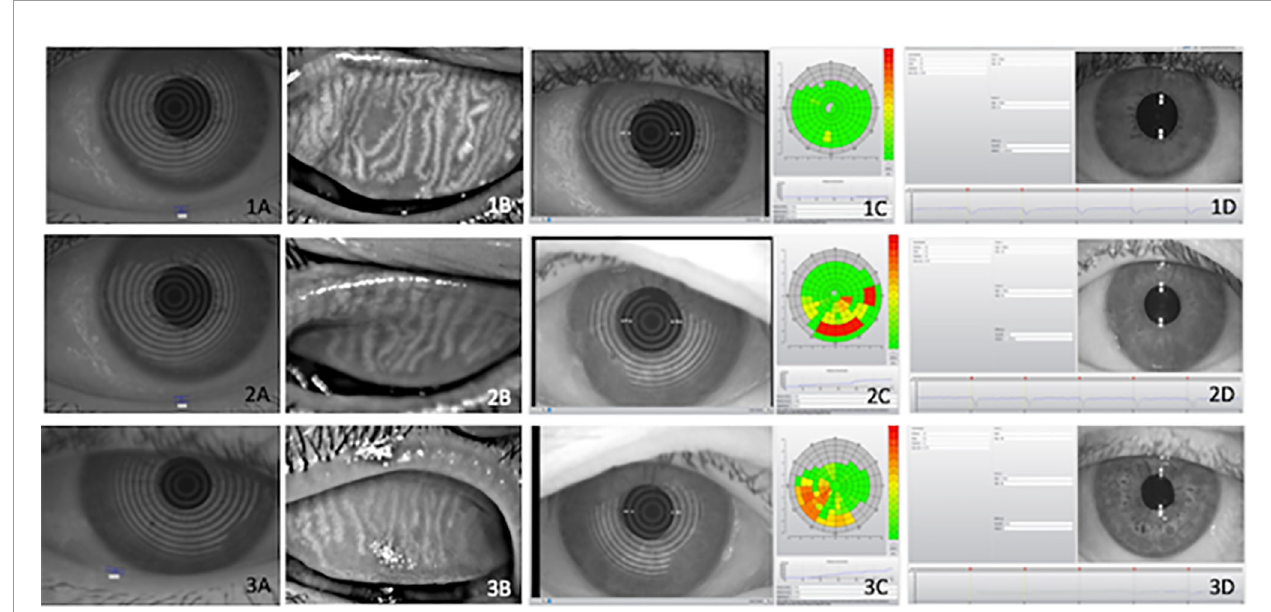
FIGURE 1 | Illustrative examples of objective ocular parameters in control (1), type 2 diabetes (T2D) patients (2) and diabetic with Charcot arthropathy (3) Tear meniscus height (A) , meibography (B) , Noninvasive Break Up Time (C) and pupillometry (D) . Ocular parameters in (1) heathy individuals; (2) type 2 diabetes (T2D) and (3) patients with Charcot arthropathy. Tear meniscus height (A) ; meibography (B) ; Non-invasive Break Up Time (C) and pupillometry (D)